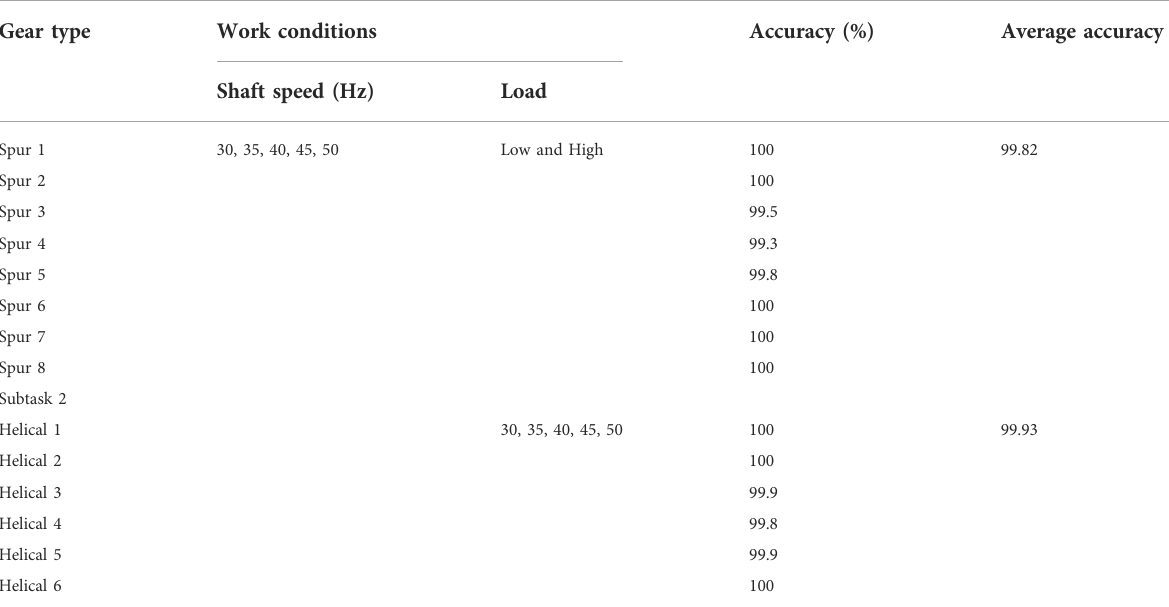
TABLE 3 Details for spur gears with different fault moods The Accuracy for different fault modes of spur and helical gears.